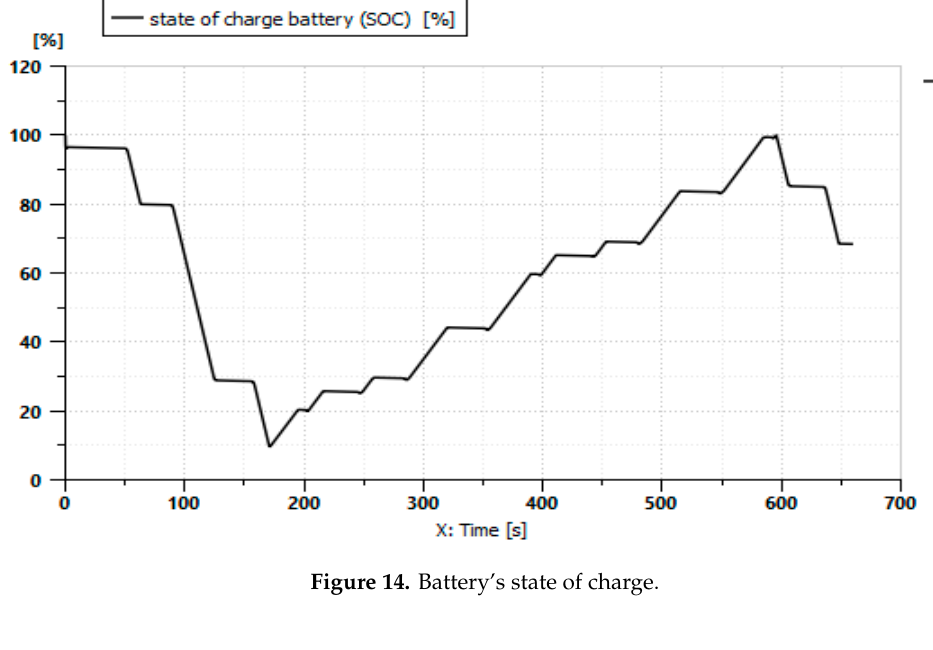
Figure 14. Battery’s state of charge.